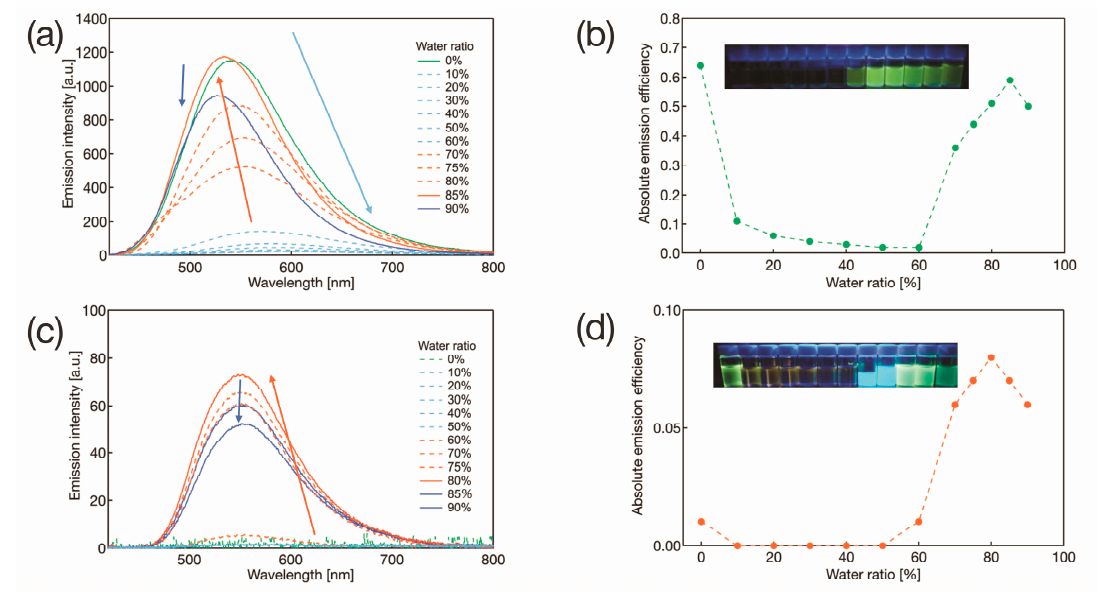
Figure 7. ( a ) PL spectra in THF/H 2 O mixed solution; ( b ) the relationship between Φ PL and water fraction of CBZ-F ; ( c ) PL spectra in THF/H 2 O mixed solution; ( d ) the relationship between Φ PL and water fraction of PIP-F . Insets: the photographs of the states of light emission irradiated by a UV lamp ( λ ex : 365